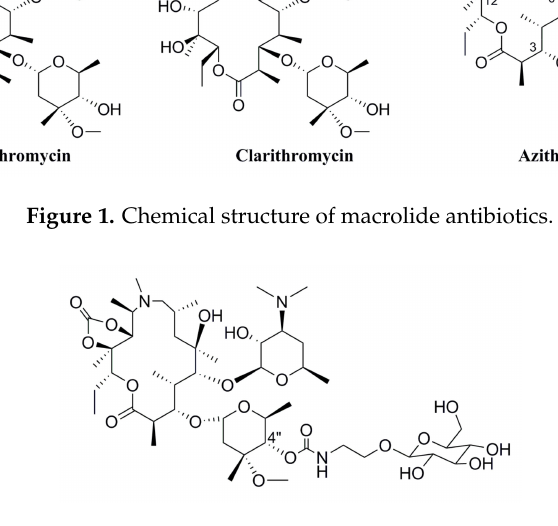
Figure 2. Chemical structure of compound F1